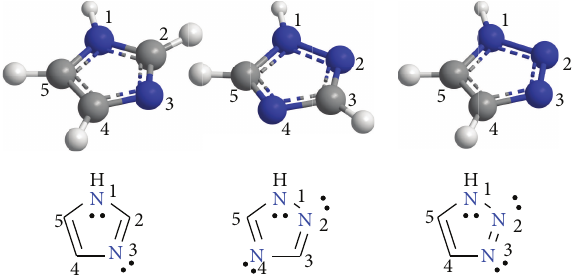
Scheme 4: Structure and numbering of the imidazole